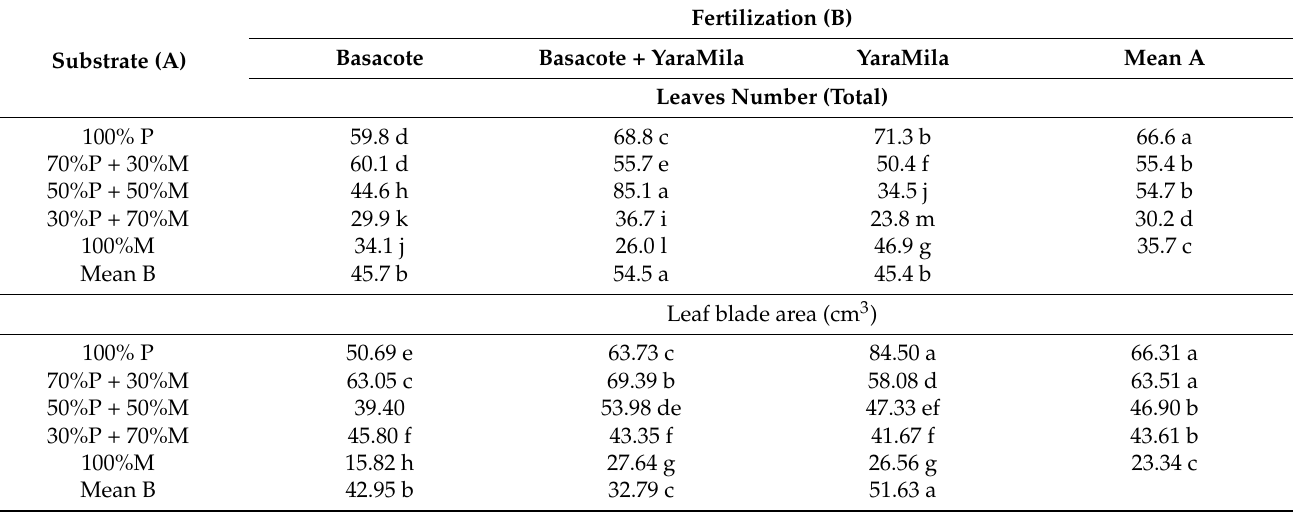
Table 5. Selected leaf features of Hydrangea arborescence ‘Annabelle’ grown in containers with five different